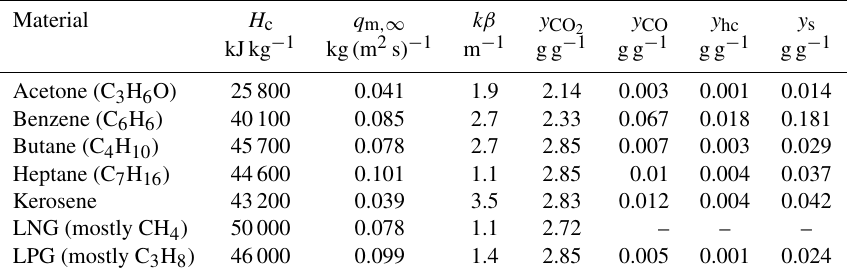
Table B1. Examples of the fuel property data (Babrauskas, 1983; Hurley, 2016). The quantities H c , q m , ∞ , and kβ are defined in the text, and y CO , y CO , y hc , and y s are the yields of CO 2 , CO, hydrocarbons, and soot, respectively. Dashes indicate that either there are no measurements 2 or their values are less than